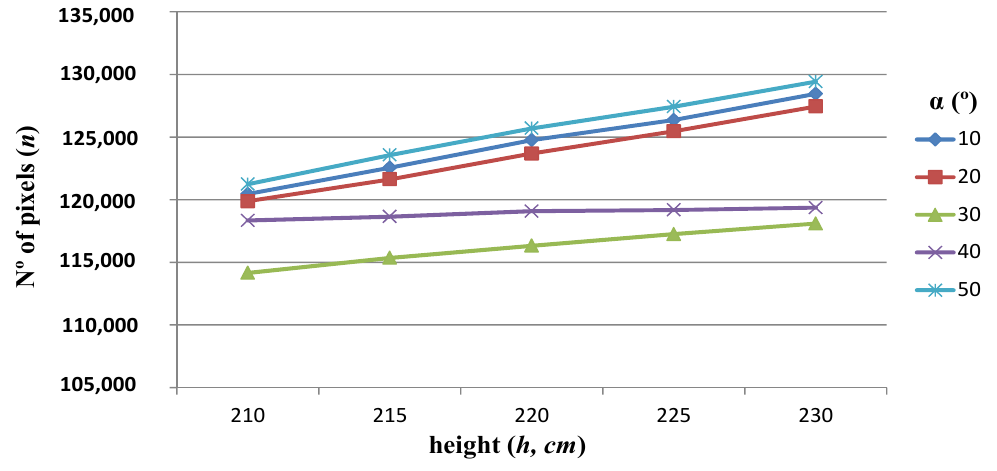
Figure 9. Number of pixels n, against h , for five different pitch angles α , at a fixed distance d = 3 m. (dot means Decimal point or thousand, please change to comma if dot refer to thousand, the same to Figure